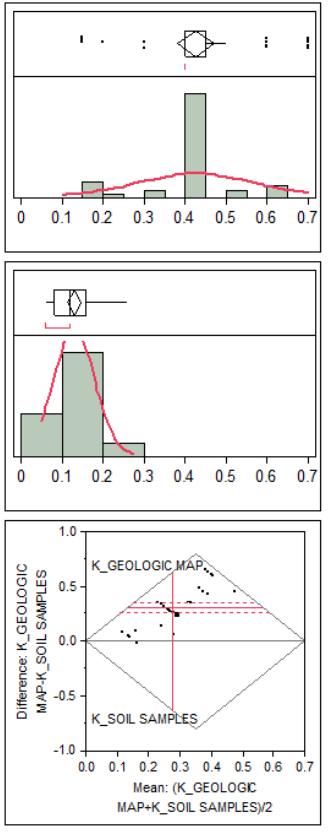
Figure 7. Top: distributions of K-values derived from the geologic map; middle: distributions of K-values derived from the soil samples; bottom: matched pairs analysis of the